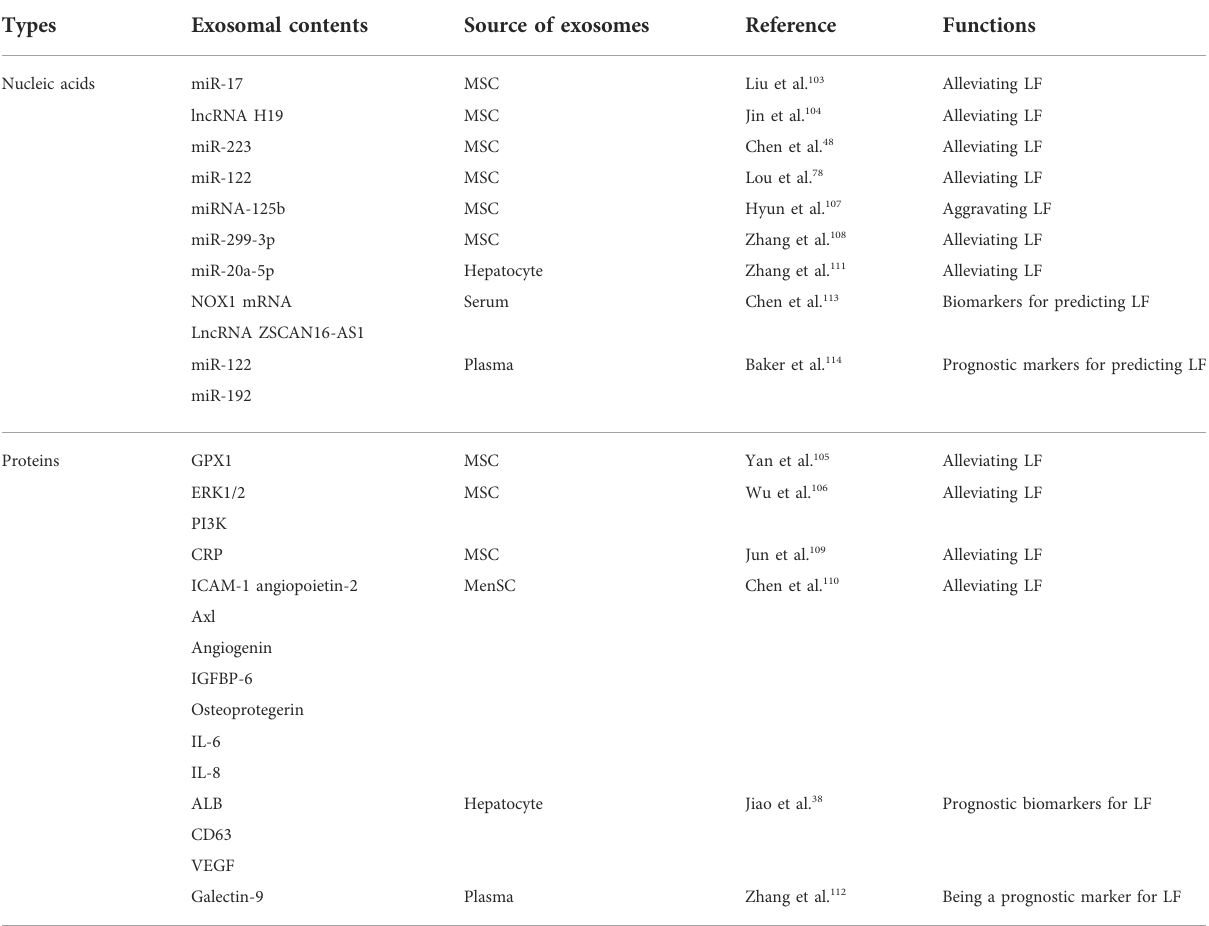
TABLE 4 Function of nucleic acids and proteins carried by exosomes on liver failure.